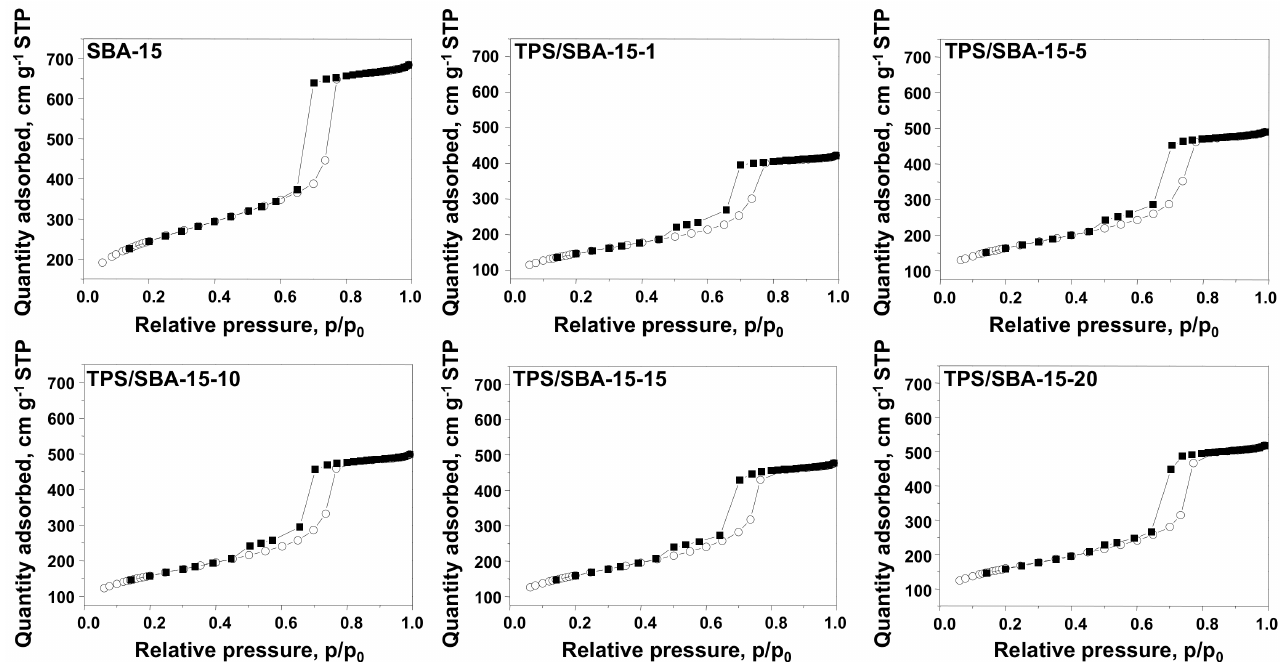
Figure 2. N 2 adsorption( )/desorption( (cid:4) ) isotherms of SBA-15 and TPS-containing (cid:35)